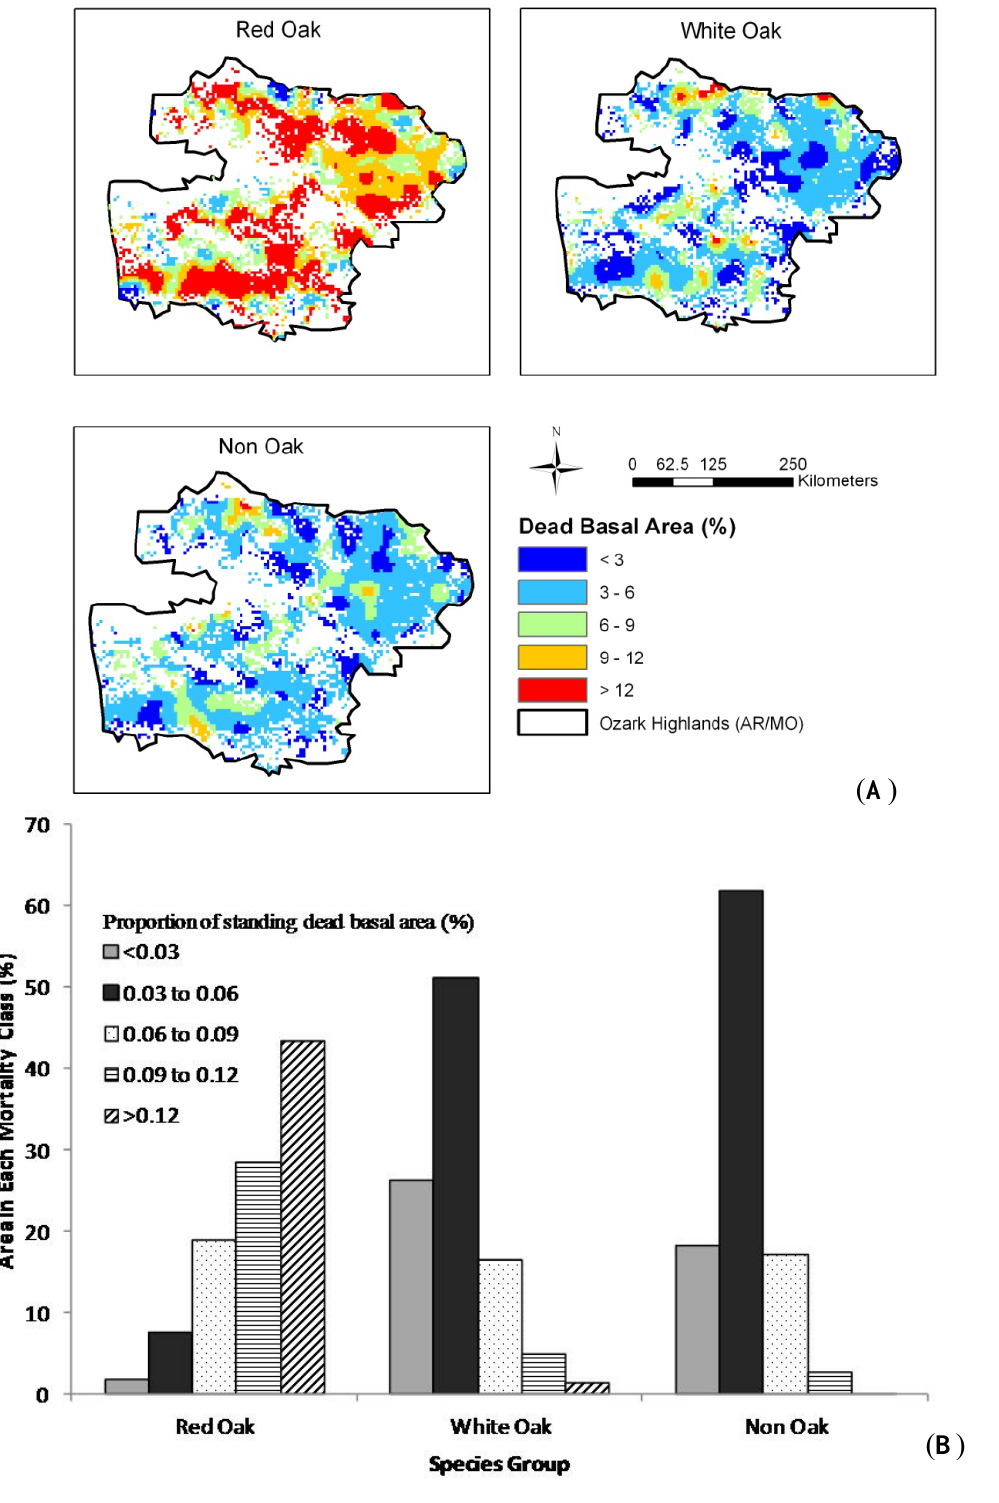
Figure 3. ( A ) Spatial trend, by mortality group for the Ozark Highlands and ( B ) area in each mortality group by species group,